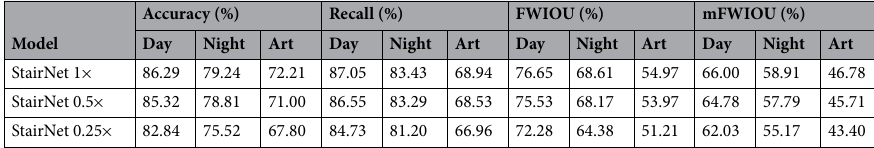
Table 4. Results of the model accuracy experiments.